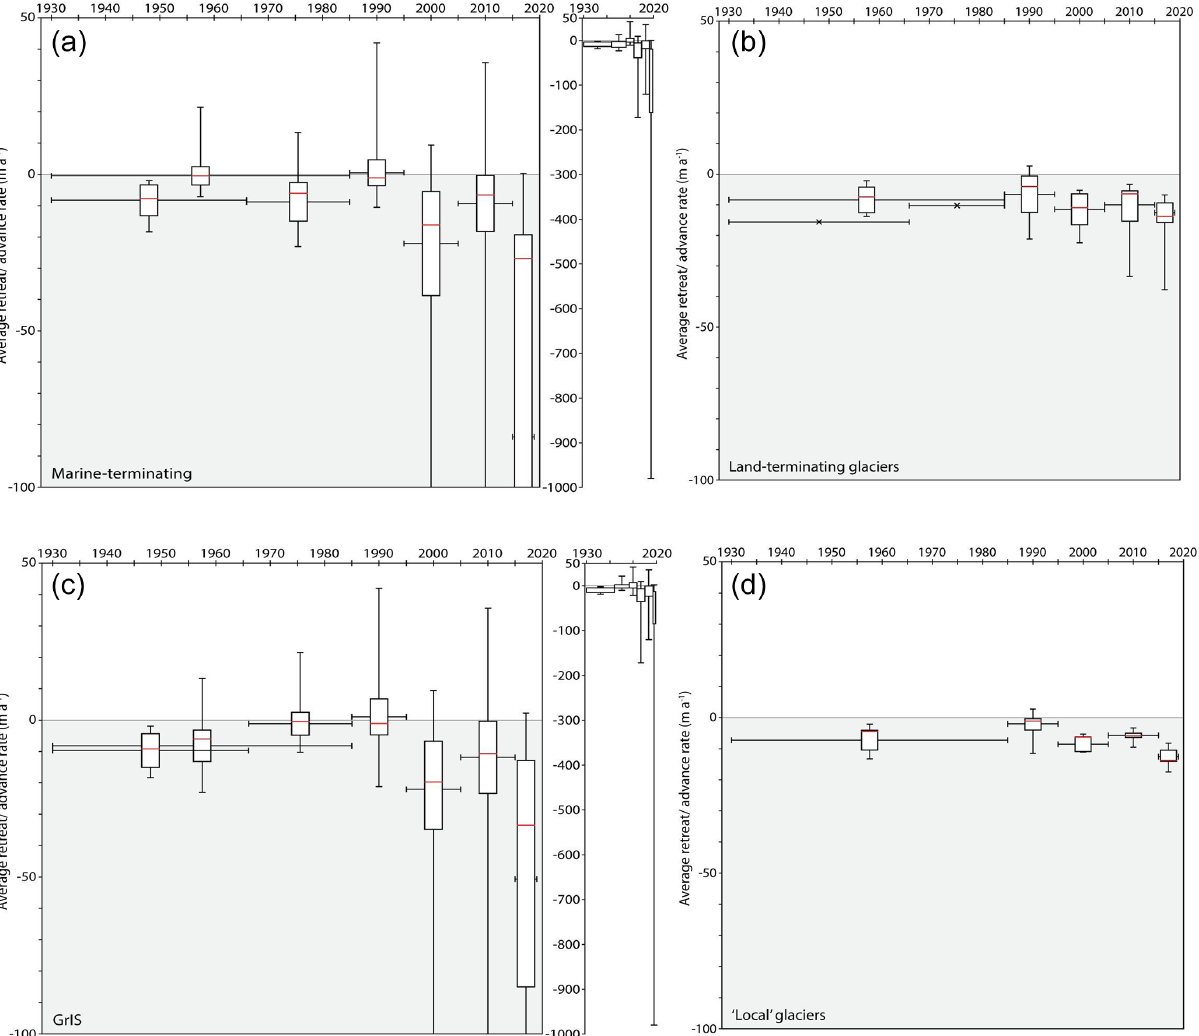
Figure 6. Box plots showing magnitude of change (i.e. advance or retreat) over the different time-steps. Vertical bars represent the range of measurements of change across all our glaciers, whilst horizontal bars represent the time period covered by a particular box. The box itself shows upper and lower quartiles with the median change in red and the whiskers show the maximum and minimum values. Here, we divide all glaciers under investigation across both regions (i.e. north and south) by type. We differentiate between marine-terminating glaciers (a) and land-terminating glaciers (b) of the Greenland Ice Sheet; and then also make a distinction between the behaviour of all outlets of the GrIS (c) and GICs that are peripheral to the GrIS (d) . In addition, the narrow central plots are duplicates of the plots associated with marine-terminating glaciers (a, b) and all GrIS outlets (c, d) but with enlarged y axes to show the full extent of error